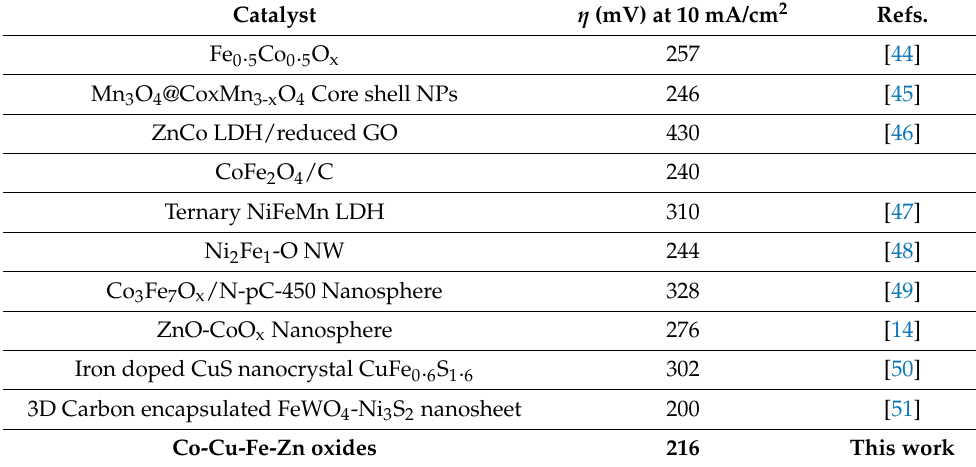
Table 3. Comparison of different metal-based heterogeneous catalysts for oxidation of water in KOH. Catalyst η (mV) at 10 mA/cm 2